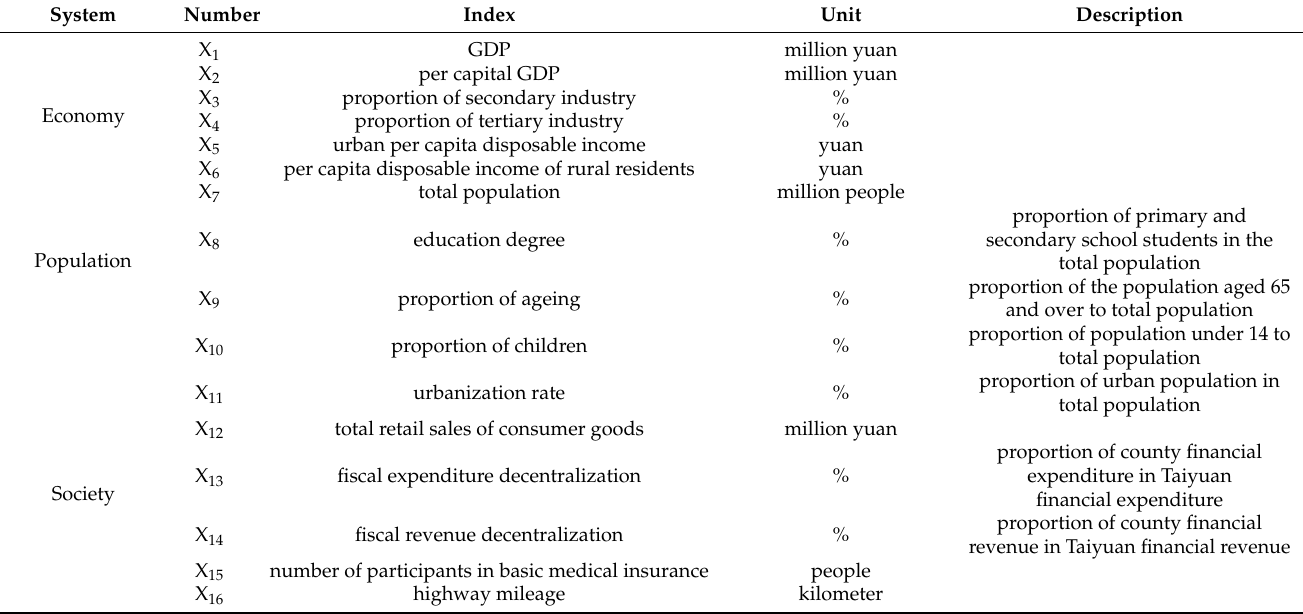
Table 1. Index system of influencing factors of medical and health resources allocation in